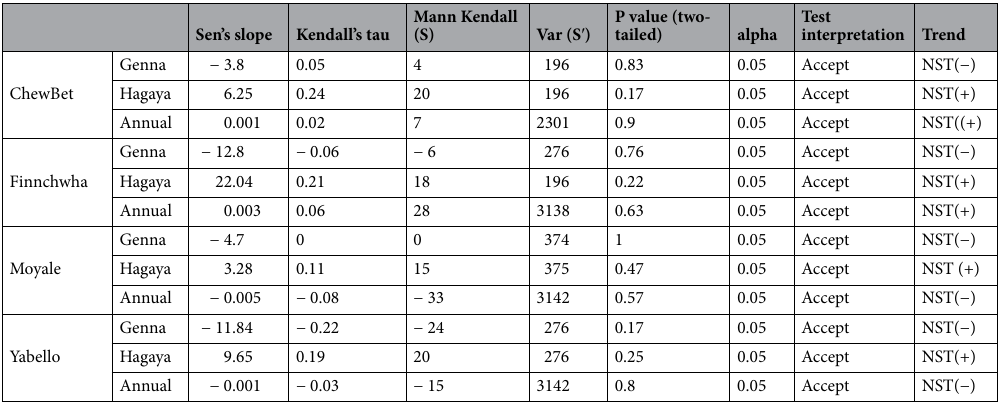
Table 4. Seasonal and annual precipitation MK test results at selected stations in the Borana zone. Source (Author): Computed based on data from the NMA of